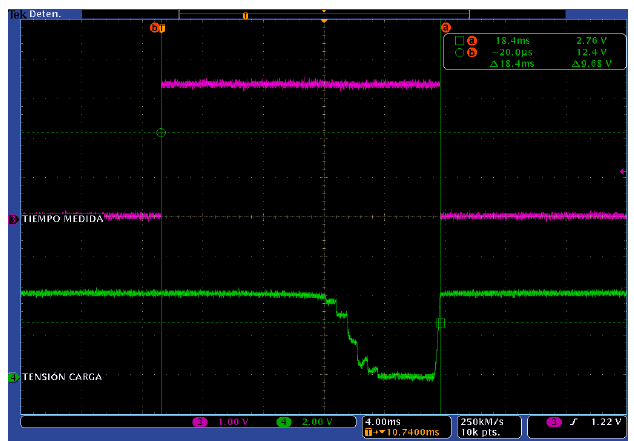
Figure 5. Panel output voltage values (green) in the characterization process sweeping resistor values in the PV panel load. Rising and descent slope in purple signal indicates the start and end time in the measurement. Time span is below 20 ms (see cursor measures).